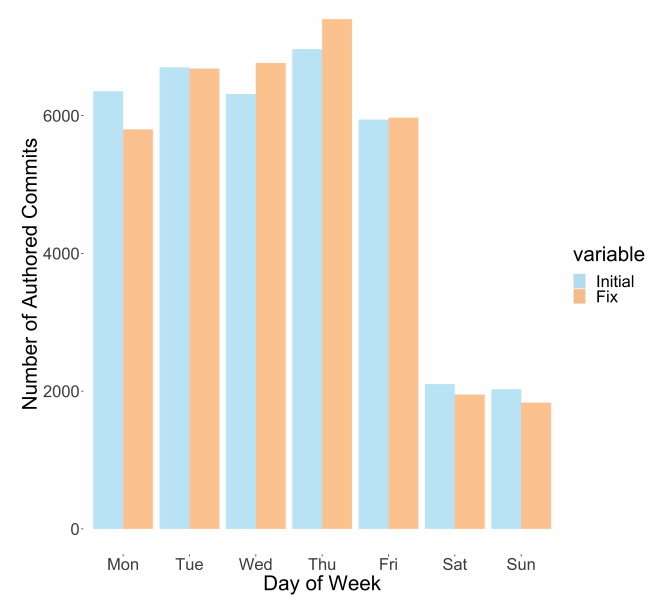
Figure 1. Buggy commits made per day of the